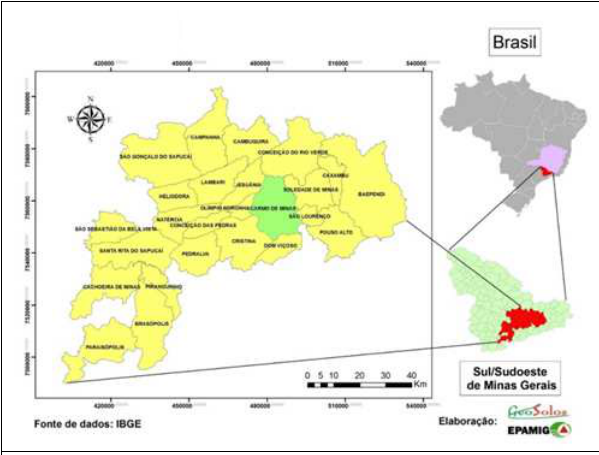
Figure 1. Location of the municipalities that constitute the IG Mantiqueira de Minas in the state of Minas Gerais and Brazil. RapidEye satellite images were used to map the land uses. The scenes with less cloud cover from 2009 were selected. The original spatial resolution of each band is 6.5 meters, but after the ortoretification each band was re-sampled to a 5 meter resolution, resulting in corrected images whose precision is compatible with a 1:25.000 scale.